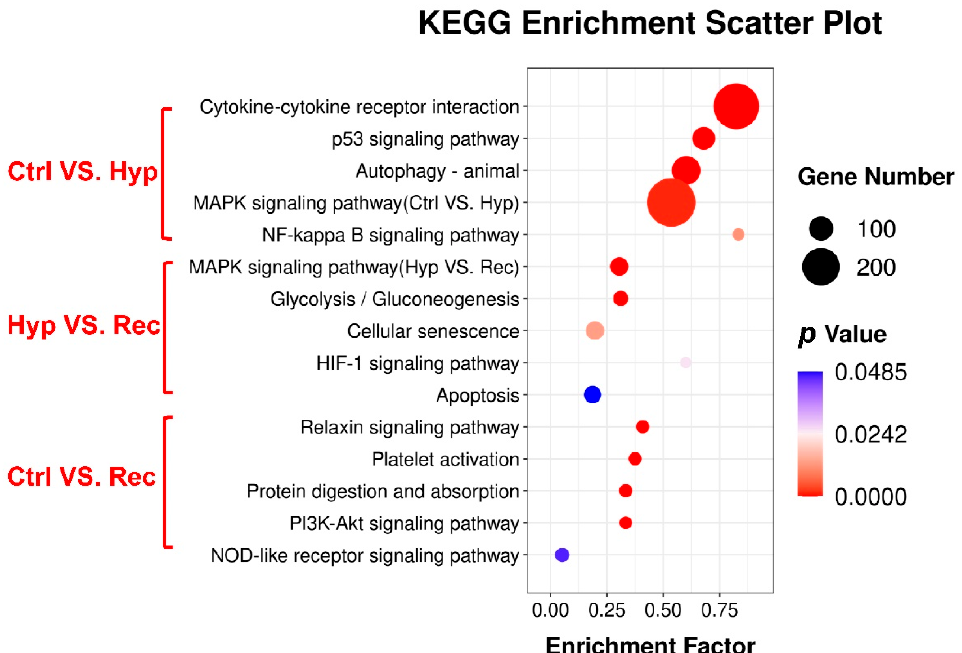
Figure 6. KEGG pathway enrichment analysis of DEGs in the intestine of largemouth bass under acute hypoxic stress ( n = 3).